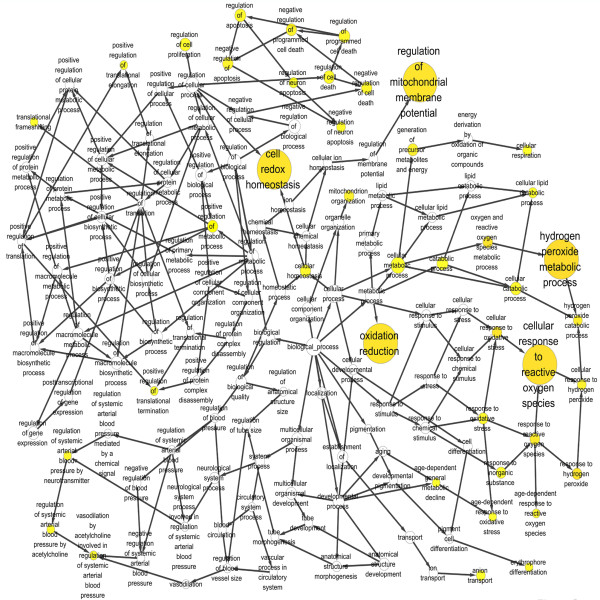
Enriched biological processes of differentially expressed mitochondrial proteins between metastatic 5-8F and nonmetastatic 6-10B cells. A circle represents a biological process. An arrow represents the relationship between two biological processes. The color from white to deep yellow represents different p-values.